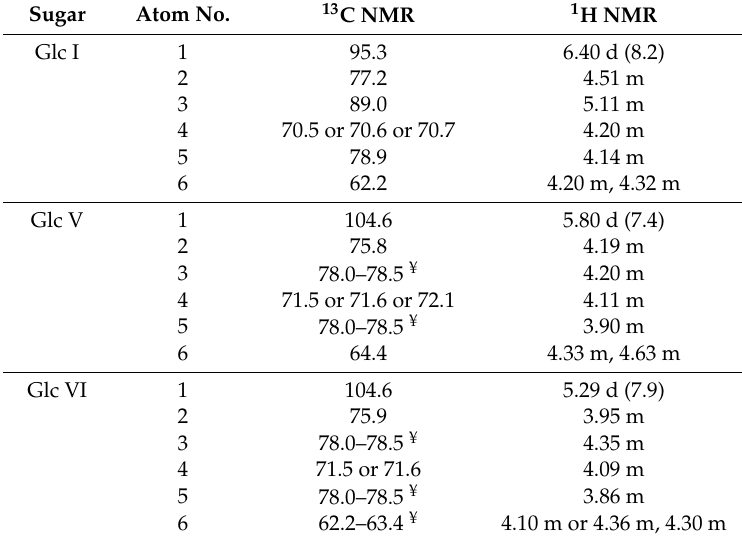
Figure 3. Summary of key Heteronuclear Multiple Bond Correlation (HMBC) and Correlation Spectroscopy (COSY) correlations used to assign the C-13 and C-19 glycoside region of compound ( 1 ). Table 2. 1 H and 13 C NMR (500 and 125 MHz, 300 K) assignments of the C-19 glycosides of compound ( 1 ) in pyridine- d 5 .